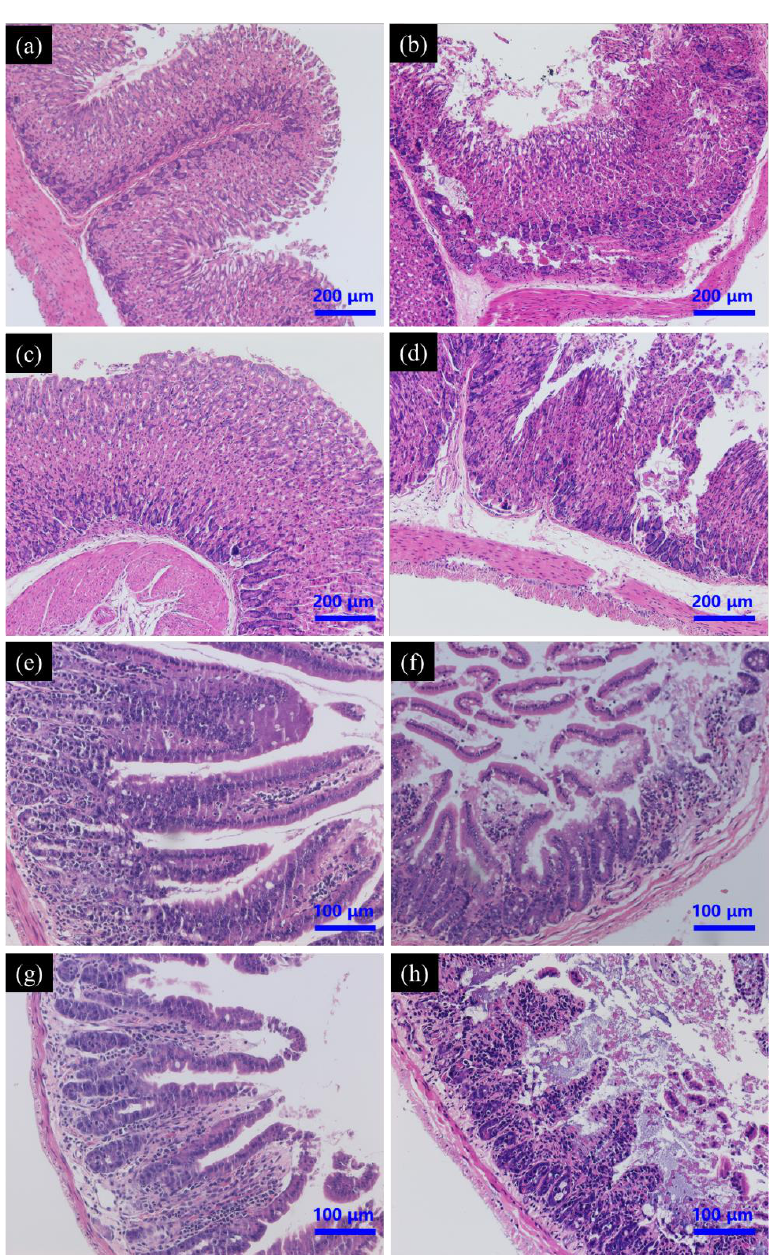
Figure 7. Effect of SeNPs on PAT-evoked pathological damage of stomach ( a – d ) and intestine ( e – h ) as assessed by H&E staining. Control group ( a , e ); PAT treatment group ( b , f ); SeNPs treatment group ( c , g ); SeNPs pre-treatment followed with PAT administration ( d , h